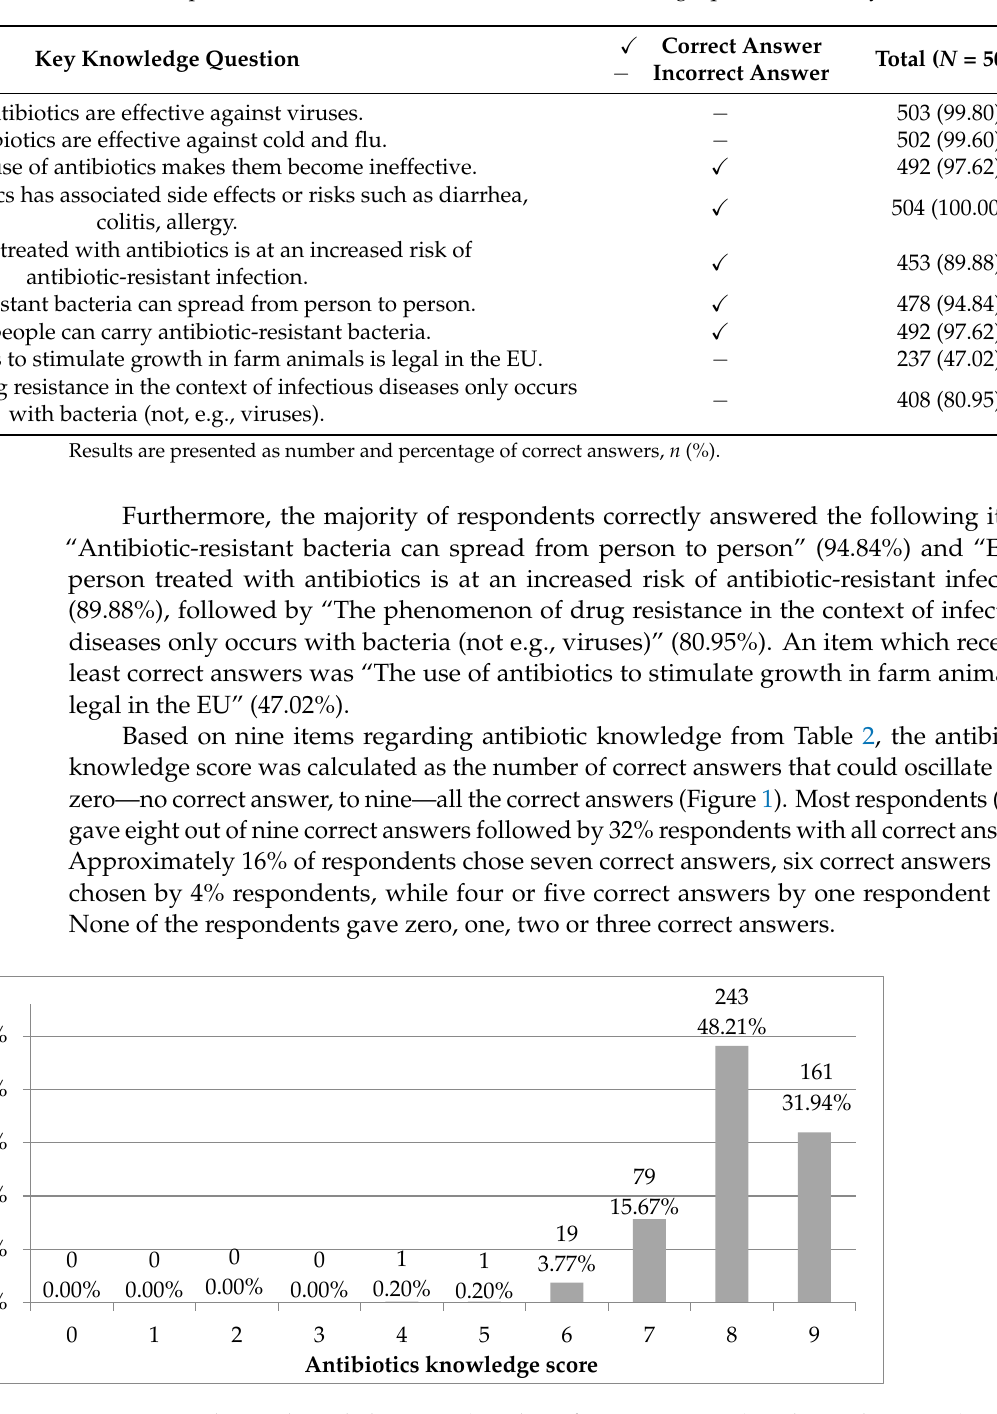
Table 2. Respondents who answered each antibiotic knowledge question correctly.